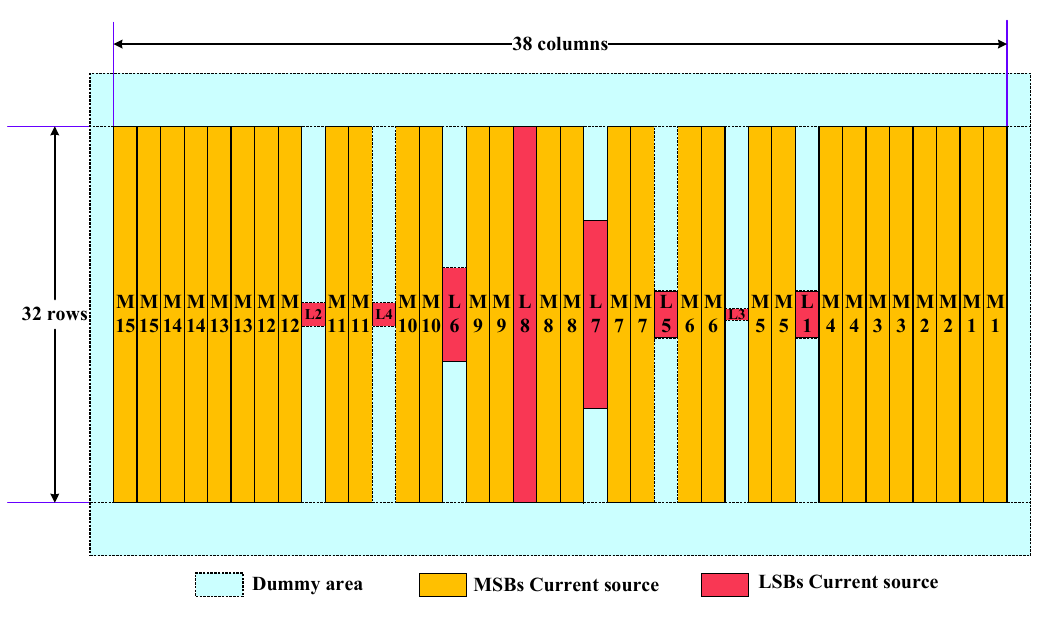
Figure 4. Switching current sources array design.